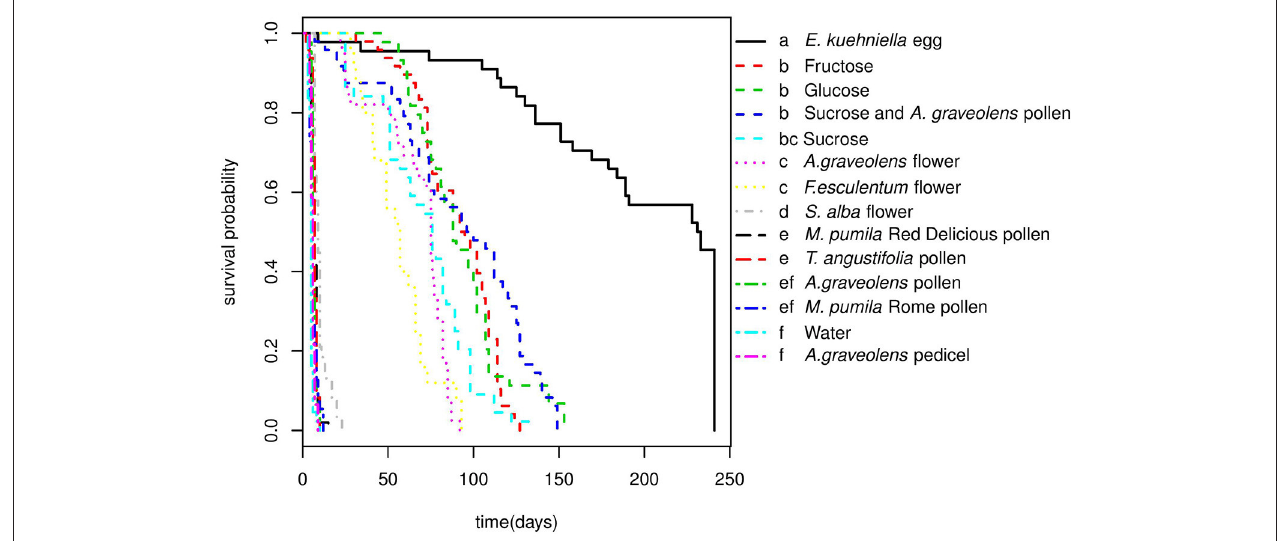
FIGURE 2 | Survival curves of A.bipunctata adults (females and males) fed on different diets. Different letters indicate significant differences among treatments after pairwise comparisons of the survival curves ( p < 0.05).